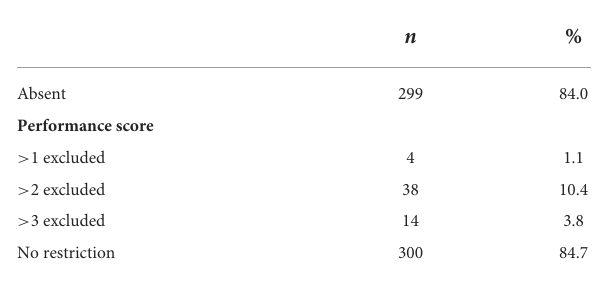
TABLE 2 Enrollment criteria in clinical trials in cancer-related